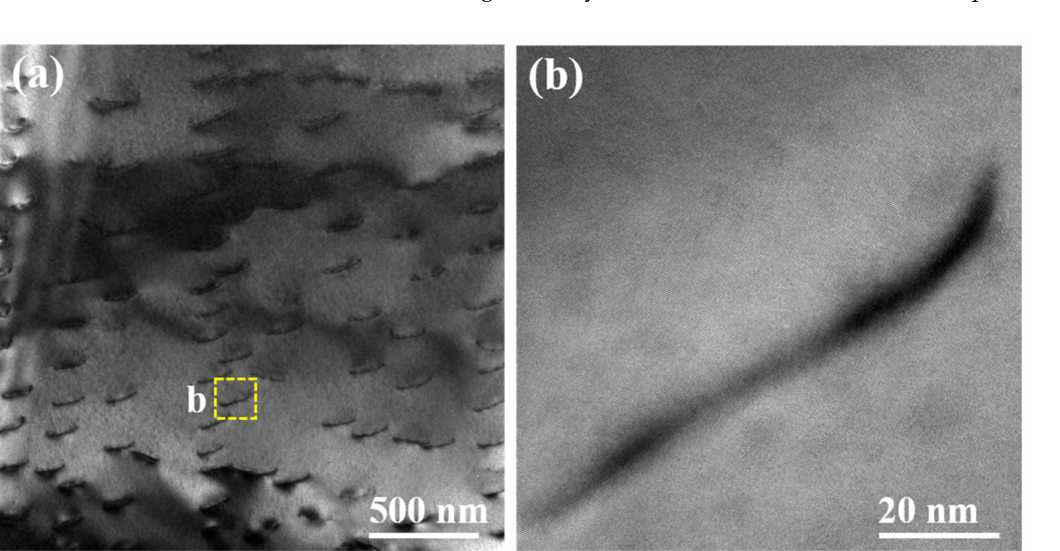
Figure 7. Fine microstructure of the CHCM sample with 30% deformation. ( a ) Low-magnification TEM images showing a high density of line defects, ( b ) the enlarged view image of the yellow rectangle area in ( a